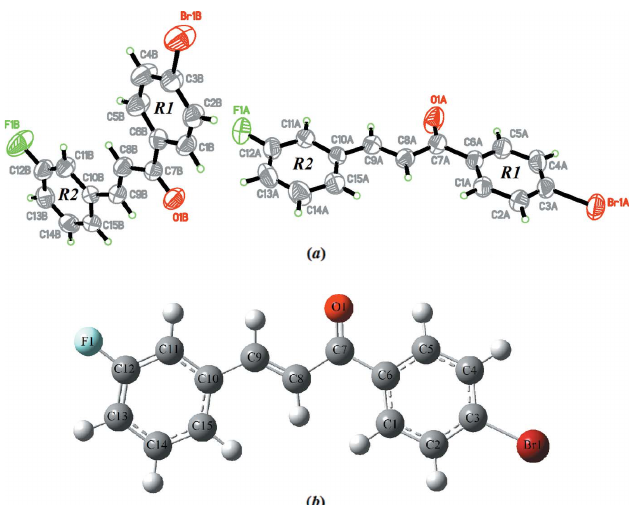
Figure 2 Crystal packing of the title compound showing C—H (cid:2)(cid:2)(cid:2) O hydrogen bonds (dotted lines). H atoms not involved in hydrogen bonding are omitted. The insets show the formation of ( a ) R 2 R 2 (6) and R 2 (10) ring 2 1